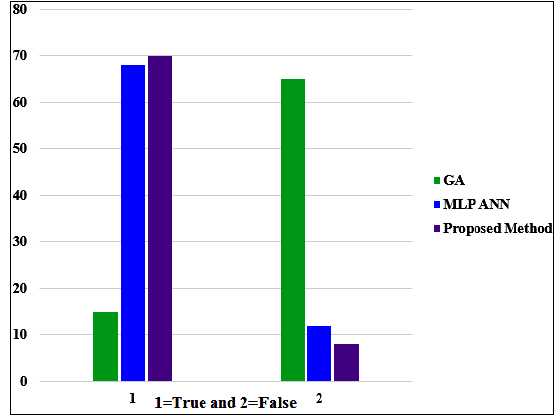
Figure 4. Comparison of proposed method with other two algorithms over training dataset.